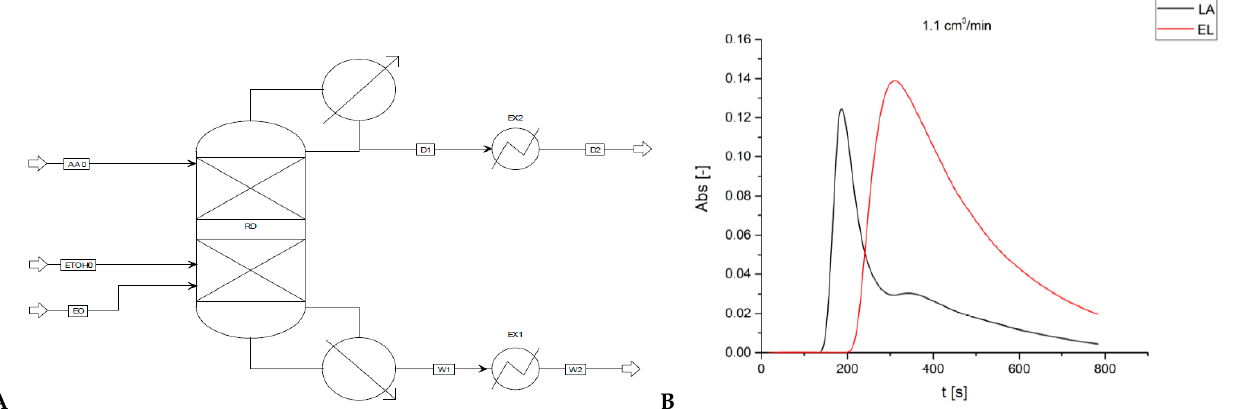
Figure 5. ( A ) Sketch of the reactive distillation unit for ethyl acetate synthesis [8]. ( B ) UV spectra of levulinic acid (LA) and ethyl levulinate (EL) 6 M at T =303 K and imposing a volumetric flowrate of 1.1 cm 3 /min [9].